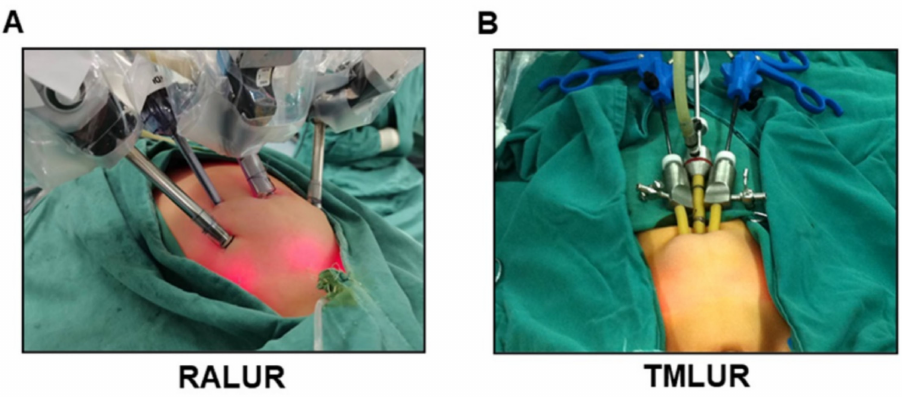
Figure 1. Patient position in RMLUR and TMLUR procedures. ( A ) Patient and trocars’ positioning in RMLUR. ( B ) Patient and trocars’ positioning in